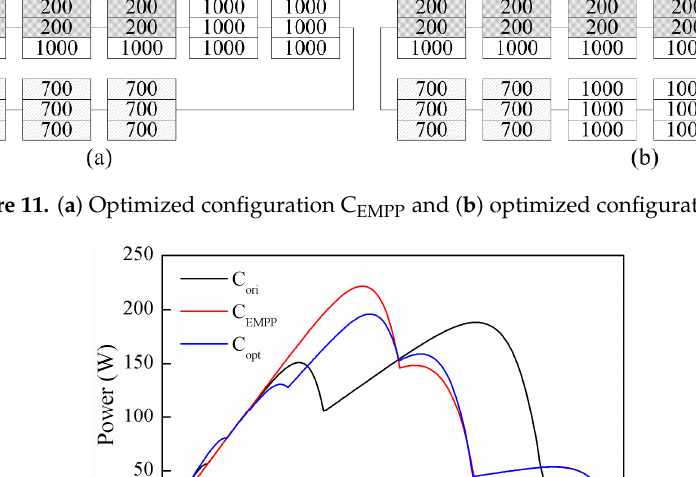
Figure 13. ( a ) Primary configuration C ori and ( b ) optimized configuration C EMPP (C opt ). Figure 14. P-V curve of a PV array before and after reconfiguration. 4.3. Case 3 For this case, the primary and optimized configurations are shown in Figure 15. The P-V curve of the PV array with a different configuration is shown in Figure 16. The global power point corresponding to C ori , C EMPP and C opt is observed at 226.5 W, 261.9 W and 253.0 W, respectively. Therefore, the reconfiguration efficiency of C EMPP and C opt are 15.6% and 11.7%, respectively. Also in this case, the proposed method had a better performance compared with the reference method. The improvement can be illustrated based on the difference between C EMPP and C opt , shown in Figure 15 (b) and (c), respectively. In both configurations, two PV panels subjected to uniform irradiance of 200 W/m 2 were disconnected from the PV array. In the eight remaining panels, the module with an irradiance of 1000 W/m 2 was the effective module. In C EMPP , 20 effective modules were evenly